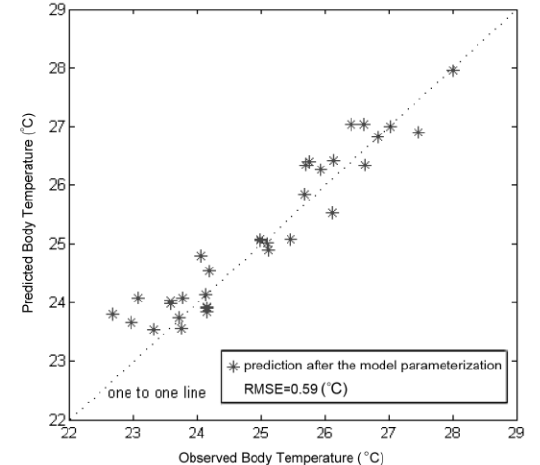
Figure 2. The simulated vs. observed body temperature of a lizard